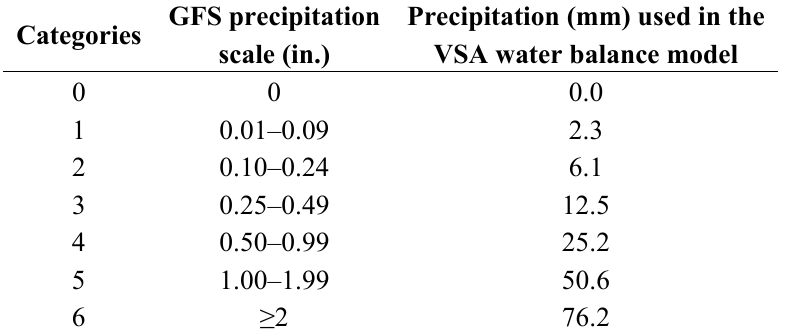
Table 1. Categories of the quantitative precipitation forecast provided with in the Global Forecast System (GFS) alphanumerical message and its usage in the water balance model.